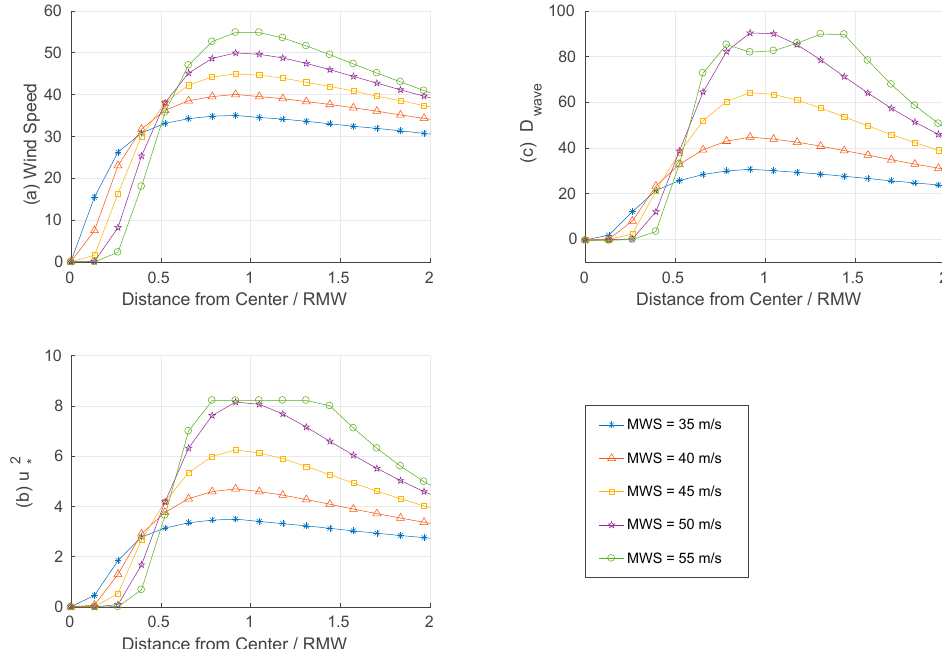
Figure 3. ( a ) Wind profile, ( b ) friction velocity squared u 2 ∗ , and ( c ) total energy flux into the wave field D wave vs. normalized distance from the center in Experiment B with RMW = 70 km.